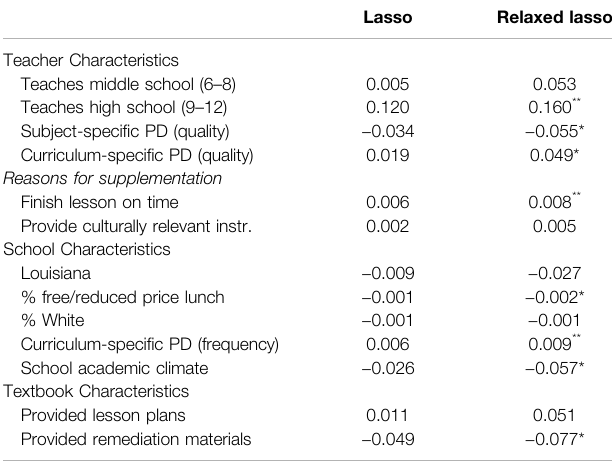
TABLE 4 | Extent of supplementation. Proportion of a teacher ’ s “ regularly used ” materials that are used with more-than-minor modi fi